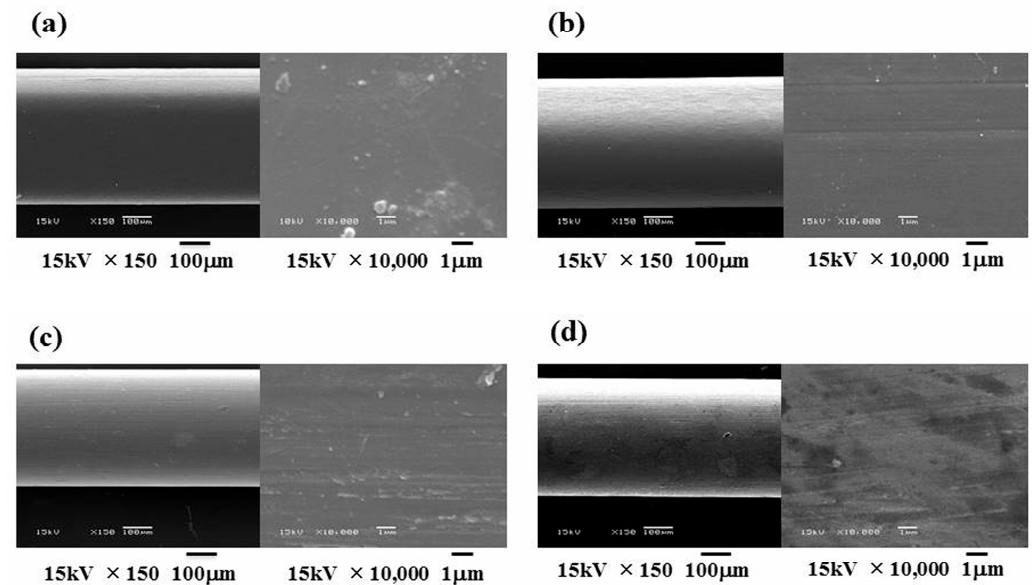
Figure 7. Scanning electron microscopy images of each wire before and after friction tests ( a ) surface of 19-25PEEK before friction test; ( b ) surface of 19-25PEEK after friction test; ( c ) surfaces of Ni-Ti before friction test; ( d ) surface of Ni-Ti after friction test.